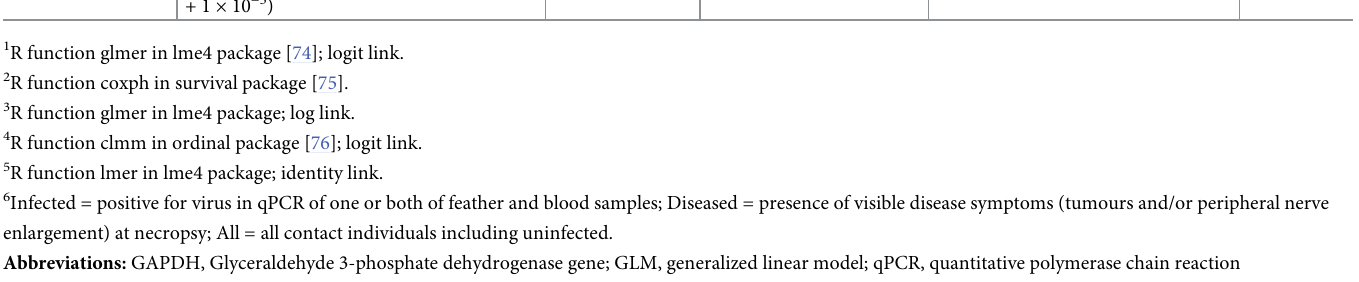
pathogen load in mediating shedder vaccination effects on contacts—details below. Nonmetric multidimensional scaling for Fig 2B was carried out in PC-ORD version 7.0 [73] statistical